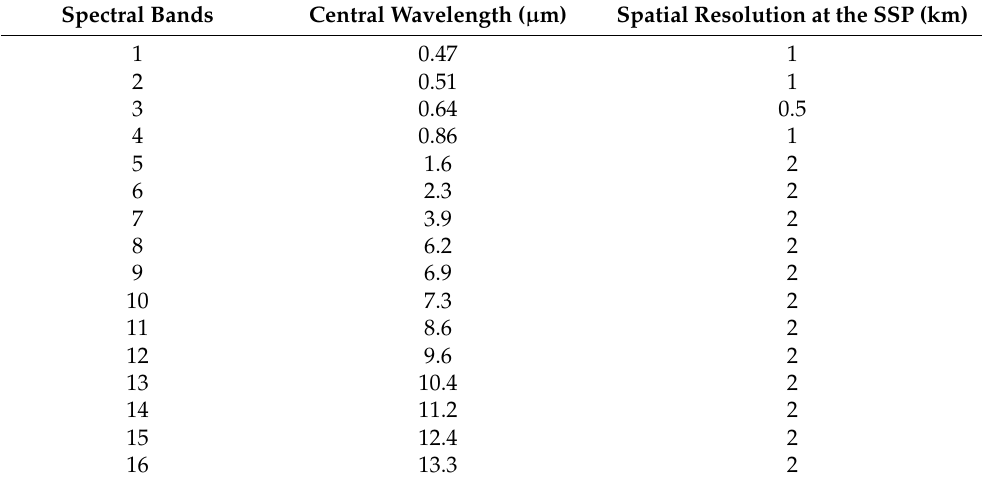
Table 1. Main features of the AHI instrument aboard Himawari-8/9 satellites.